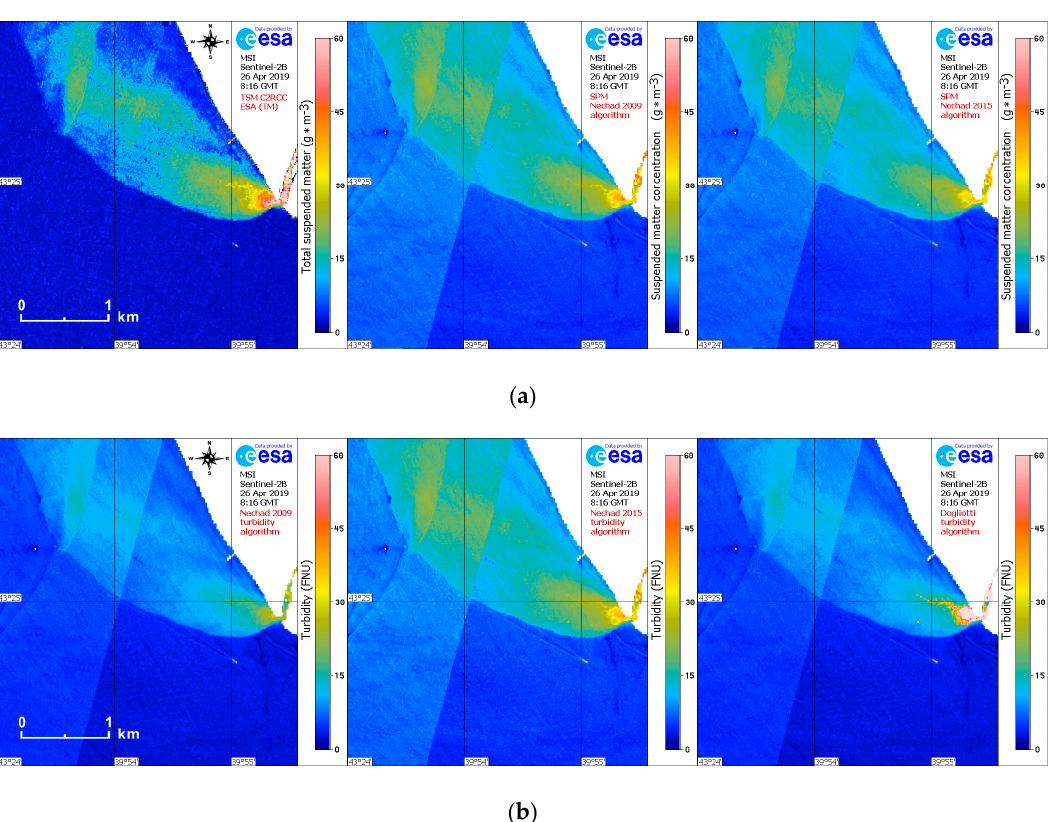
Figure 11. Performance of different satellite algorithms to map: ( a ) SPM; ( b ) turbidity, retrieved from Sentinel-2B MSI data of 26 April 2019.